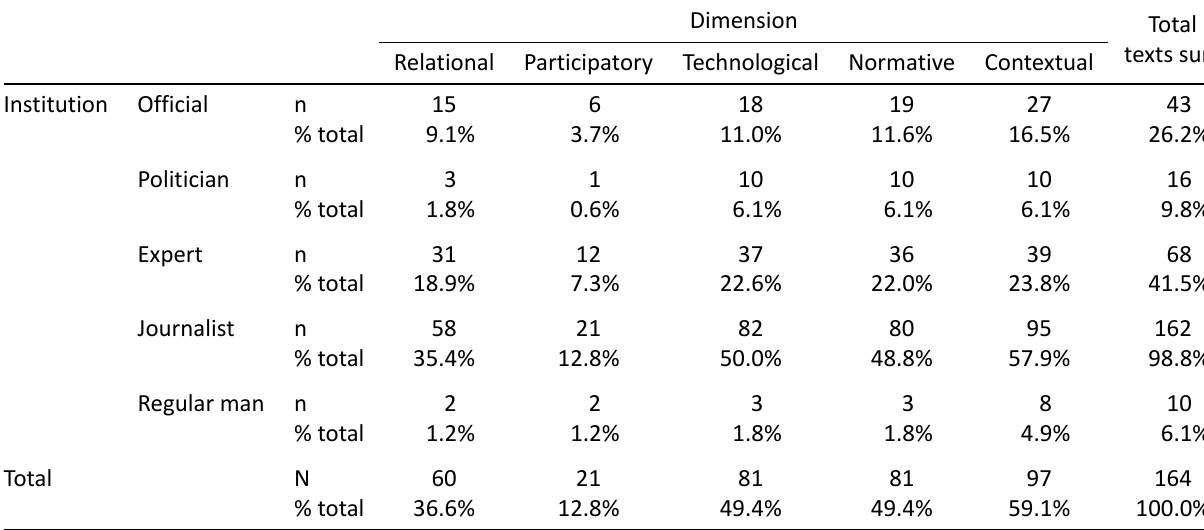
Table 2. Relation between institutions and dimensions of privacy